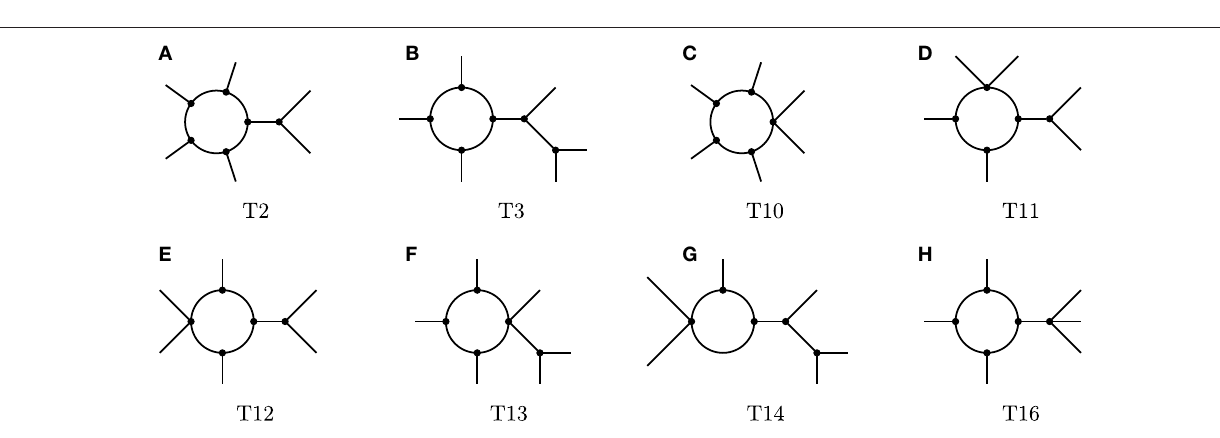
FIGURE 4 | Topologies that can give rise to genuine 1-loop openings of the dimension-7 Weinberg operator O ′ 1